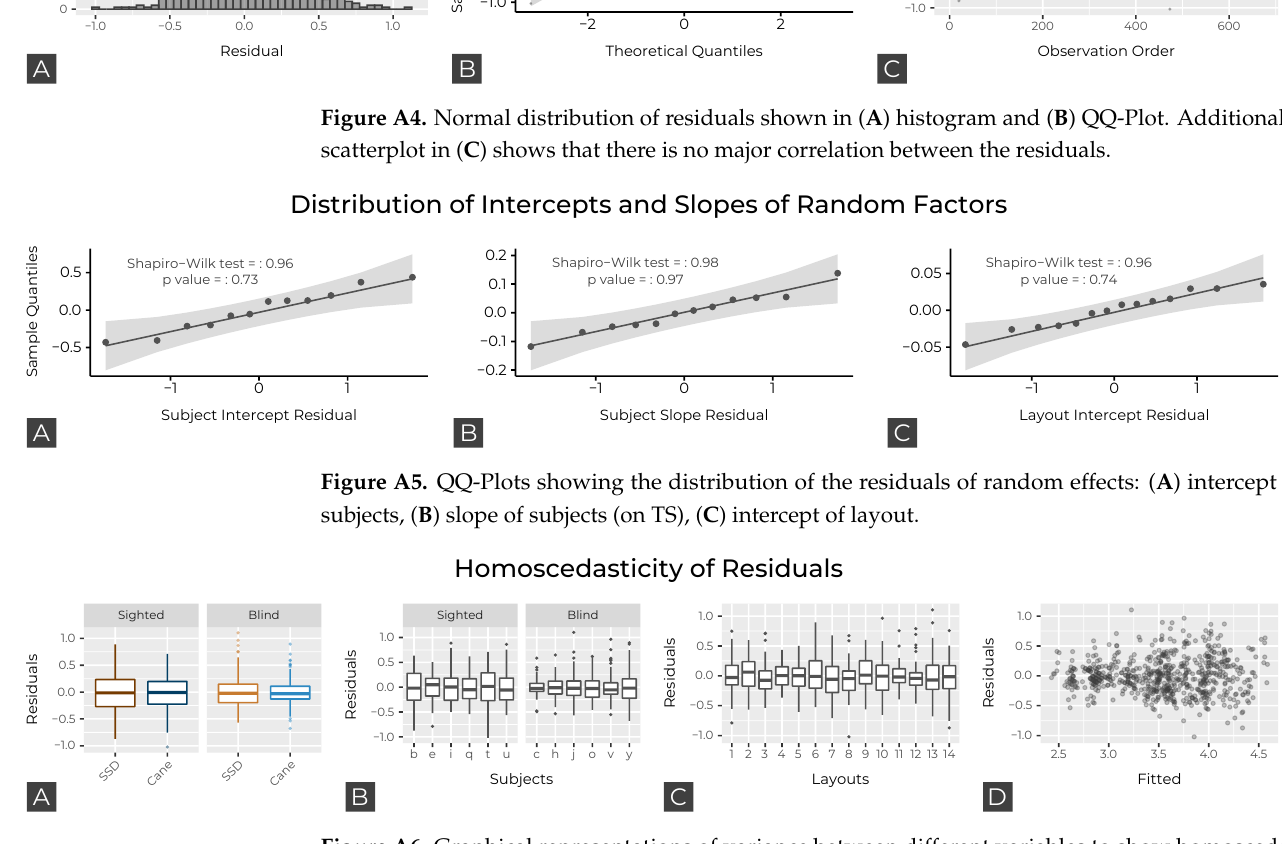
Figure A6. Graphical representations of variance between different variables to show homoscedas- ticity/homogeneity of variance: ( A ) group and aid, ( B ) subjects and ( C ) layouts. Furthermore the residuals vs. fittet scatterplot in ( D ) allows to check for non-linearity, unequal error variances and outliers. Even though the variances of the error terms seem to be slightly left-slanted, the data can be seen as reasonably homoscedastic and